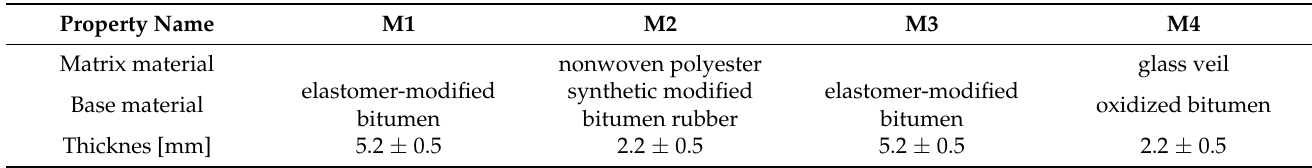
Table 1. Analyzed materials